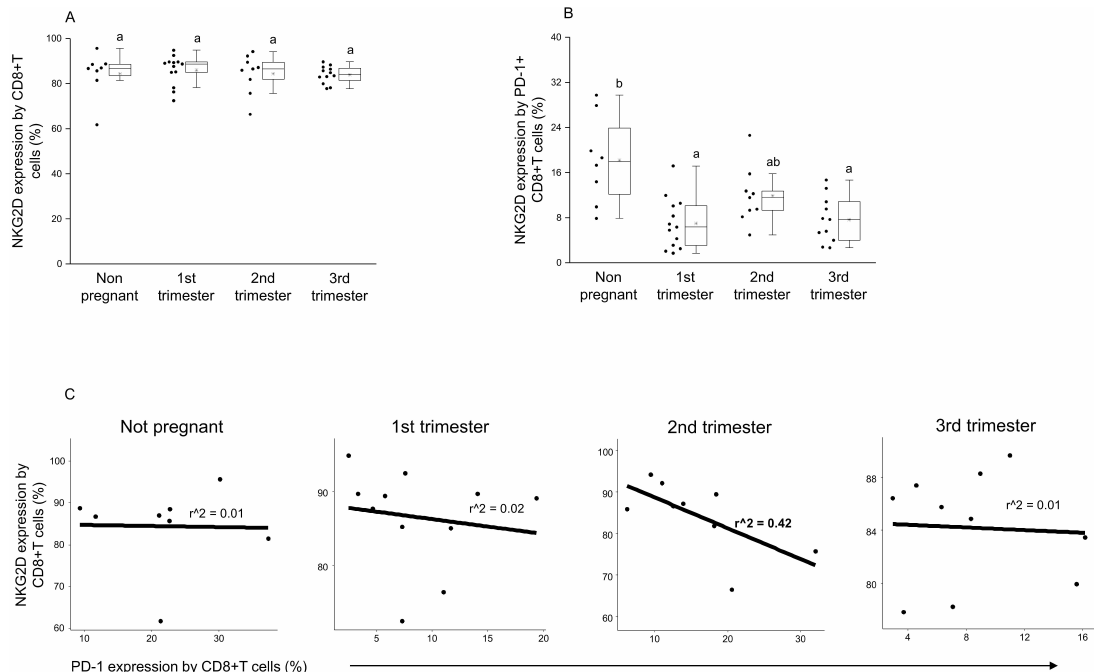
Figure 5. Connection between NKG2D activator receptor and PD-1 inhibitory immune checkpoint receptor expression on CD8 + T cells throughout pregnancy and in nonpregnant women. The surface expression of NKG2D receptor by CD8 + T cells ( A ) and PD-1 + CD8 + T cells ( B ). The solid bars represent medians of 10, 13, 10 and 12 samples, the boxes indicate the interquartile ranges and the lines show the most extreme observations. Di ff erences were considered statistically significant for p -values ≤ 0.05, Variables with the same letter indicate no statistically significant di ff erence, while di ff erent letters indicate a statistically significant di ff erence. Linear regression analyses between PD-1 and NKG2D surface receptor expressions by CD8 + T cells ( C ) in women during healthy pregnancy and in nonpregnant women. p values and coe ffi cients of determination (R2) were calculated in R. Cytotoxic potential of peripheral PD-1 positive and negative CD8 + T cells and NKT-like